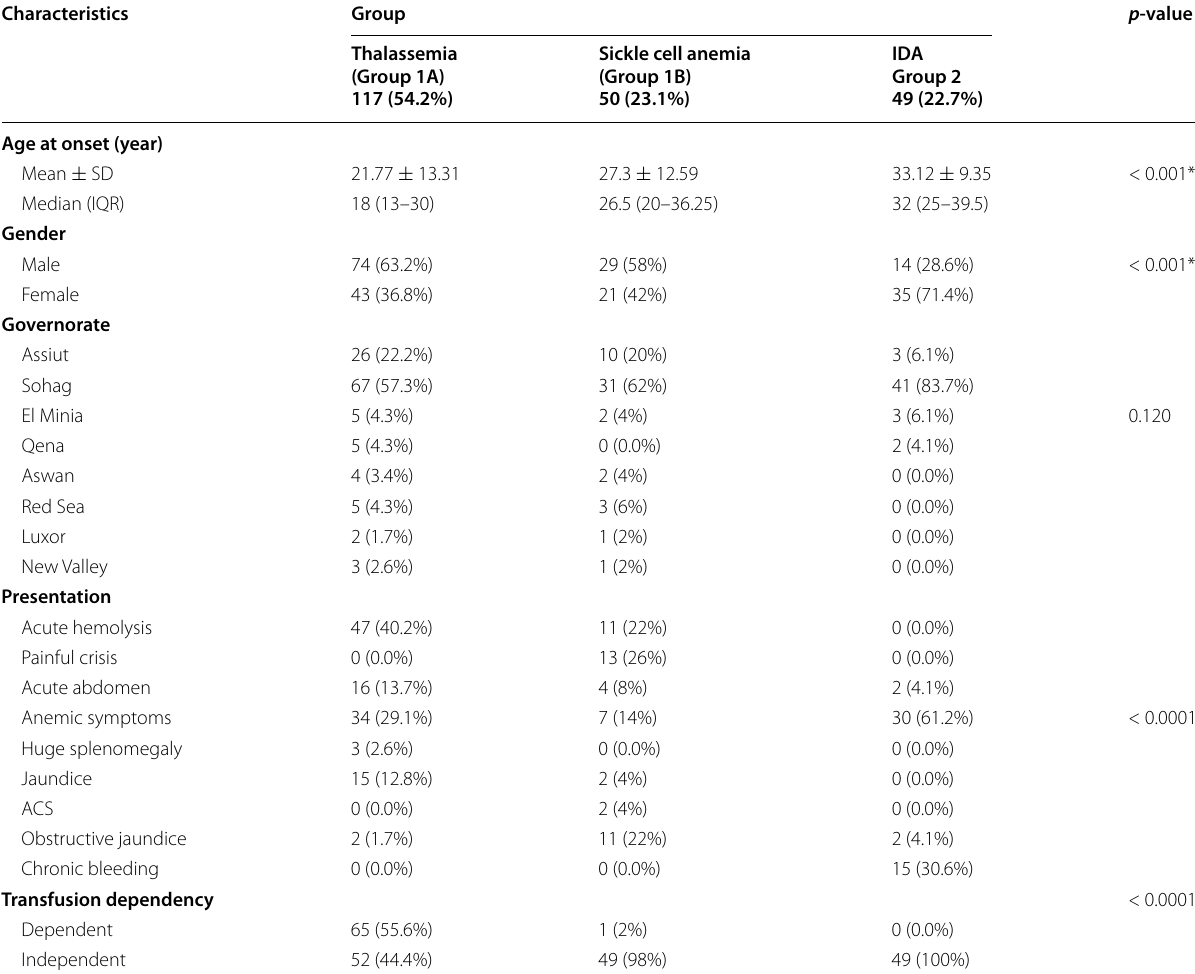
Table 1 Differences among the study patients as regard demographic and clinical characteristics and transfusion